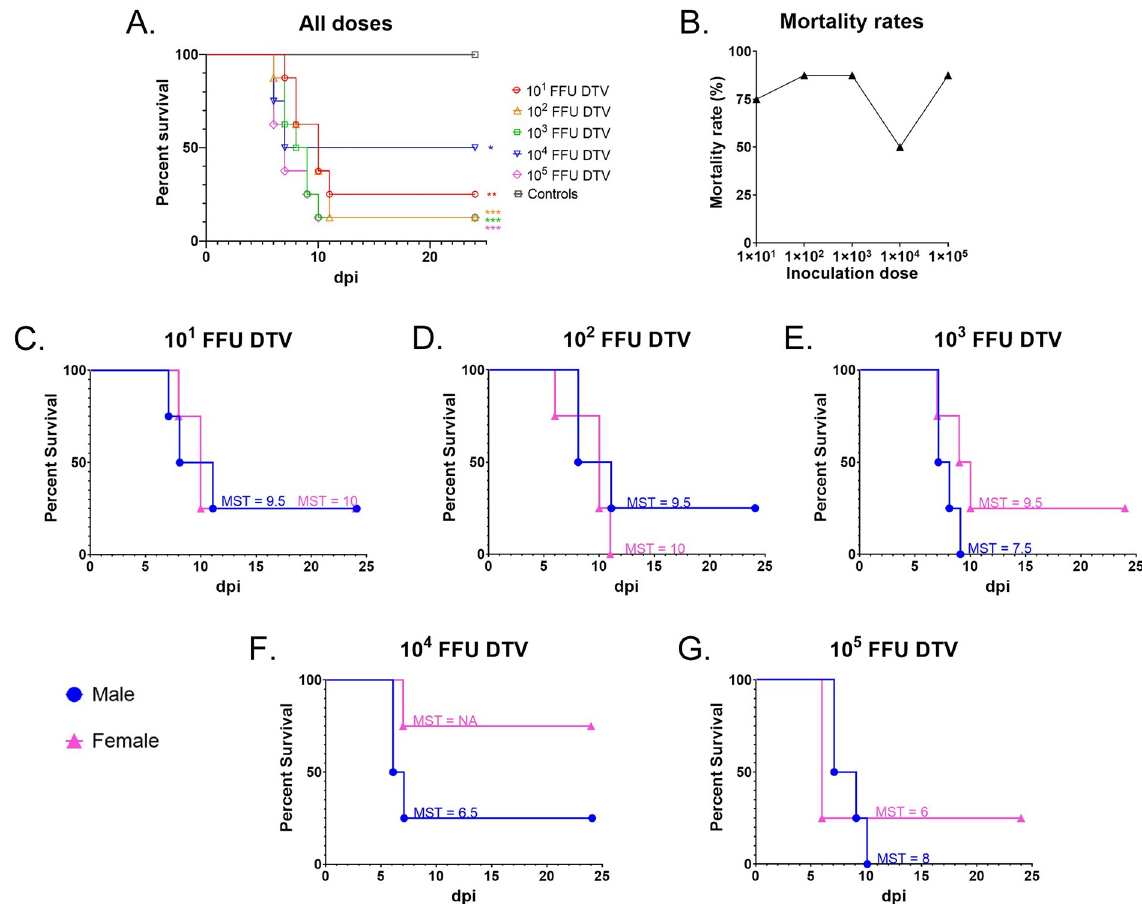
Fig 1. Mortality for DTV-infected mice. A ) Kaplan-Meier survival curves for each dose cohort (n = 8 mice per dose), including mock-infected controls (n = 8). The log-rank (Mantel-Cox) test showed statistical significance for all infection doses compared to the control group. ( � p < 0.05; �� p < 0.01; ��� p < 0.001). The log-rank test indicated no statistically significant differences in survival between the infection doses. B ) Mortality rates were recorded for each dose cohort (n = 8). C–G ) Kaplan-Meier survival curves for male (n = 4) versus female (n = 4) mice inoculated with C ) 10 1 FFU DTV, D ) 10 2 FFU DTV, E ) 10 3 FFU DTV, F ) 10 4 FFU DTV, or G ) 10 5 FFU DTV. The median survival time (MST) in days is shown for each cohort of mice. “NA” indicates that a median survival time is undefined because greater than 50% of subjects were alive at the end of the study. All mock-infected control mice survived until the end of the study and are not